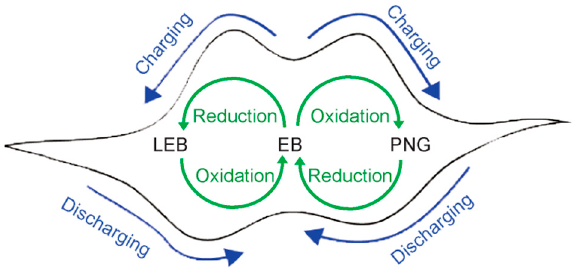
Figure 5. Schematic of the different redox transitions of aniline tetramer that occur on each electrode during device charging and discharging.